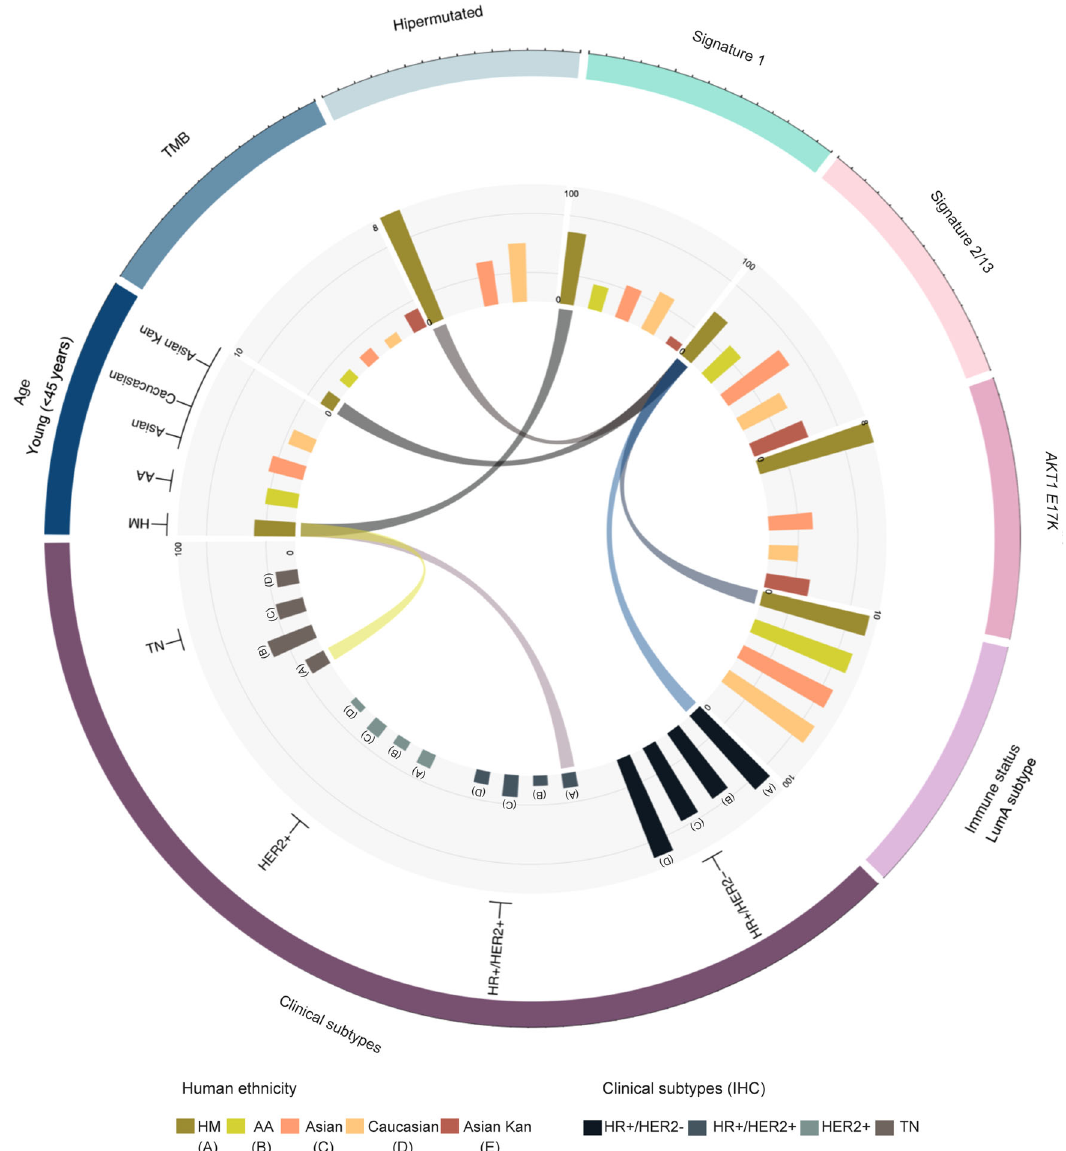
Fig. 9 Summary of our remarkable fi ndings in the evaluated HM tumors. The outer circle was divided in each molecular alteration presenting a differential status detected in our evaluated HM tumor samples against other human population. Inner circle shows barplots indicating the frequency of each phenotype as indicated in the labels ( y -axis and x -axis). Ribbon connections describe the proposed biological relation among the diverse altered “ omics ” and clinical features. LumA: Luminal